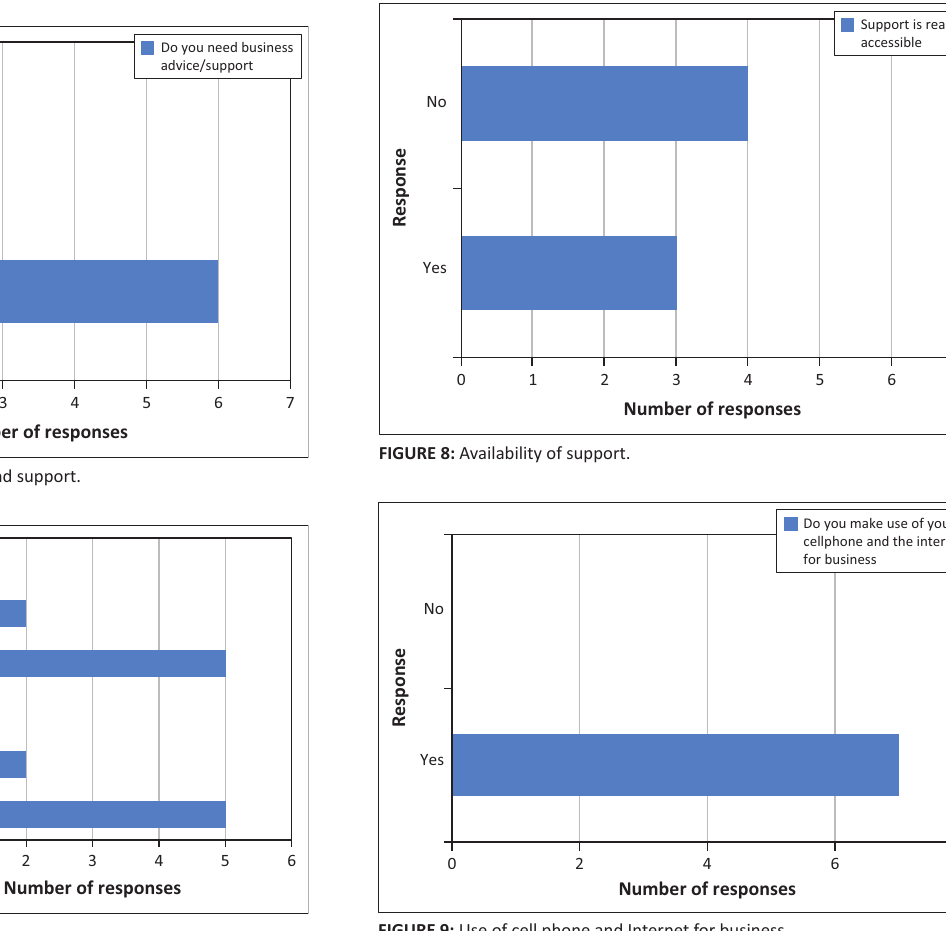
FIGURE 6: Areas for required support.